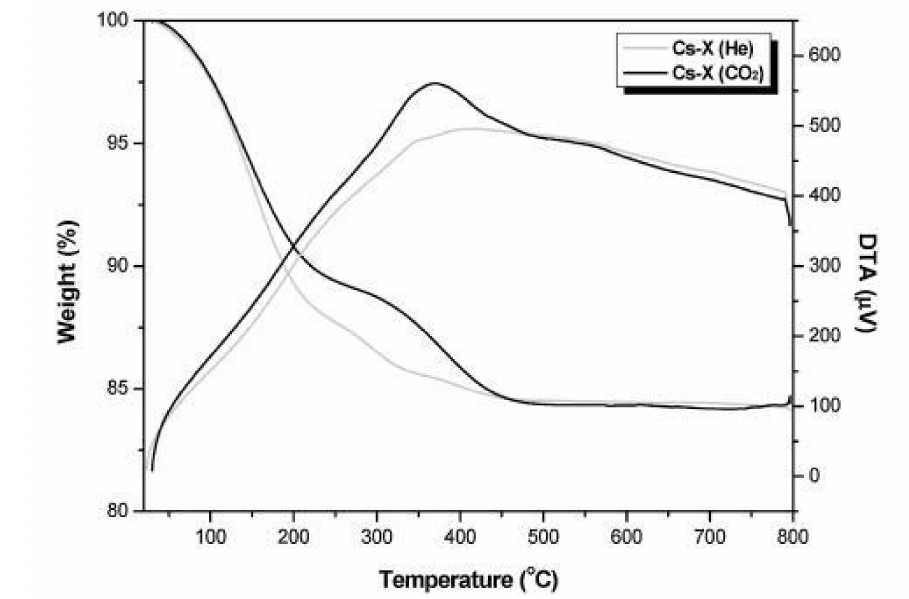
Figure 6. TG / DTA results obtained for used Cs-X catalyst in the presence of CO 2 and He streams (Redrawn with permission from [91]; copyright (2018),